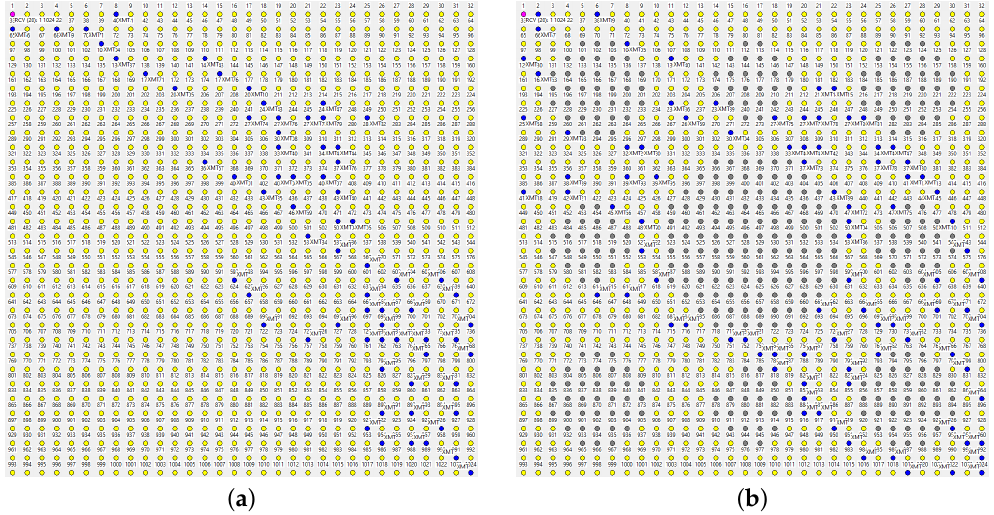
Figure 12. Paths for C = 2 and A = 0 (both within the same beacon interval). ( a ) Healthy network; ( b ) nine